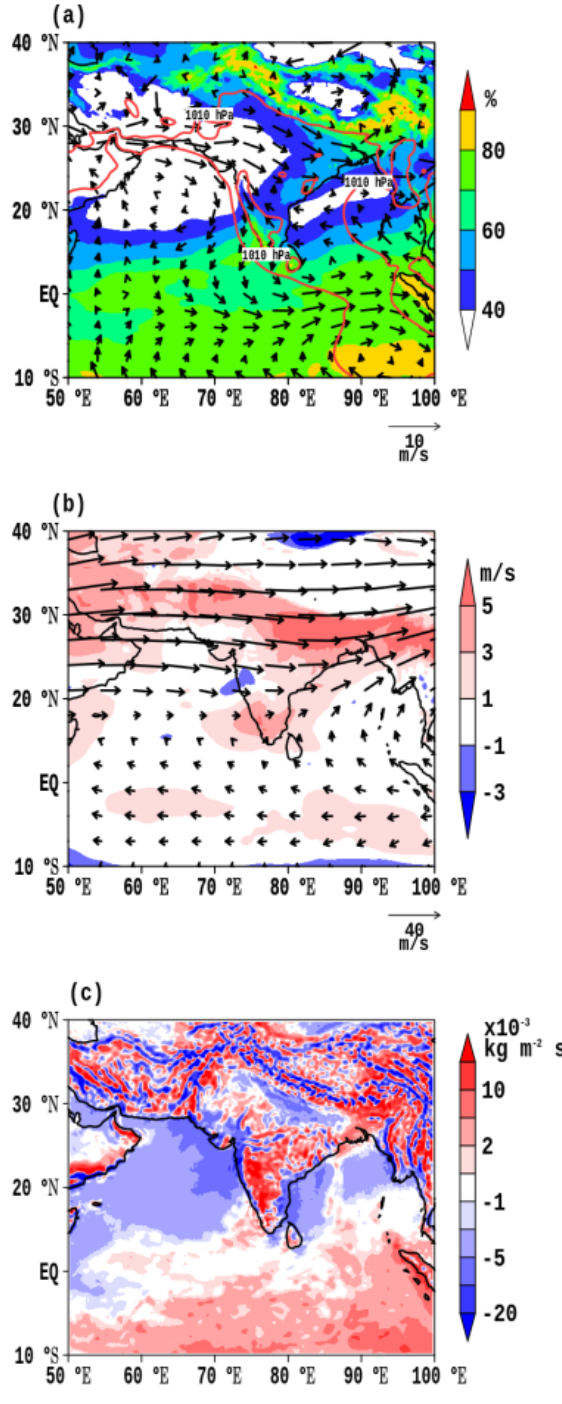
Figure 3. 2020 MAM mean ( a ) relative humidity (%; shaded), sea-level pressure (hPa; contours in red) and 850 hPa wind vector; ( b ) low-level wind shear between 850 and 700 hPa (m s − 1 ; shaded) and 200 hPa mean wind vector; and ( c ) vertically integrated moisture flux convergence (VIMFC; × 10 − 5 kg m − 2 s − 1 ). Plotted using ECMWF reanalysis (ERA5) hourly data [47]. 3.2. Evaluation of IFS Lightning Forecast In Figure 4, the mean lightning flash density is plotted for (a) the LLN observations, (b) IFS Day 1, (c) Day 2, and (d) Day 3 lead times, respectively, along with the bias between LLN and IFS forecast for (e) Day 1, (f) Day 2, and (g) Day 3 lead times. The figure shows that the IFS lightning forecasts capture the pre-monsoon lightning-prone regions rather well. However, there is positive bias along with the Himalayan foothills and a negative bias over eastern India. With increasing lead time, over-estimation across Himalayan foot- hills decreases while under-estimation over eastern India increases.